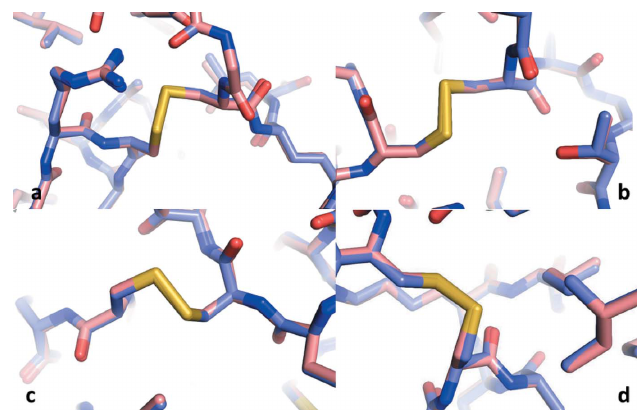
Figure 8 Superpositions of the four disulfide bonds (yellow) between our structure solution (light red) and the structure of 5uvj (light blue) solved by Martin- Garcia et al. (2017). ( a ) Cys6–Cys127, ( b ) Cys30–Cys115, ( c ) Cys64–Cys80 and ( d ) Cys76–Cys94. The average deviation for the atoms of the thiol groups is 0.12 A˚ . Changes are mostly insignificant, and only apparent in splits from light red to light blue.